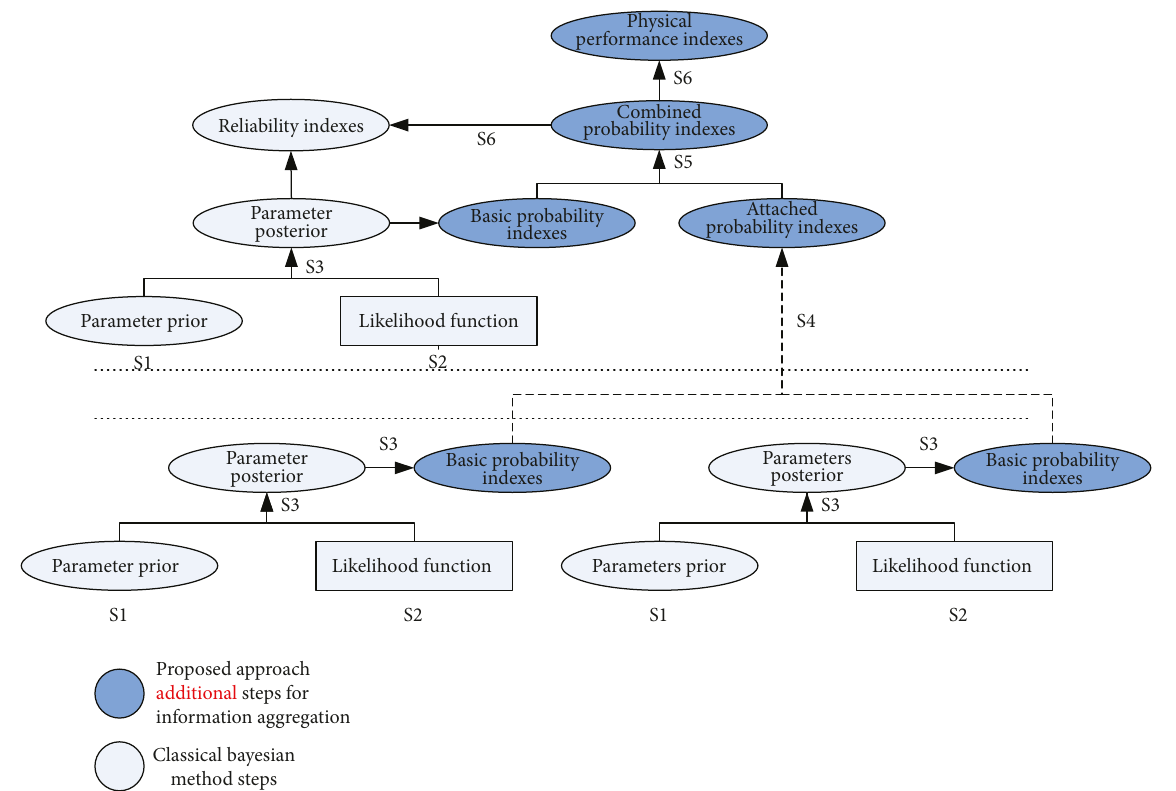
Figure 6: Framework of the proposed information aggregation approach for the MSDII